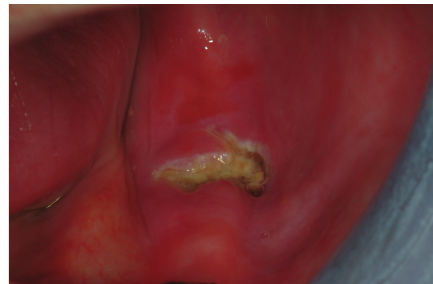
Figure 1: Osteochemonecrosis with exposed necrotic bone on the left mandibular edentulous area.